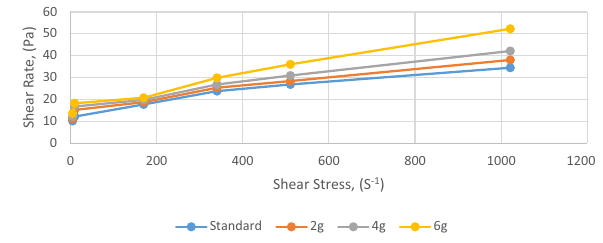
Fig. 3 A plot of shear rate against shear stress